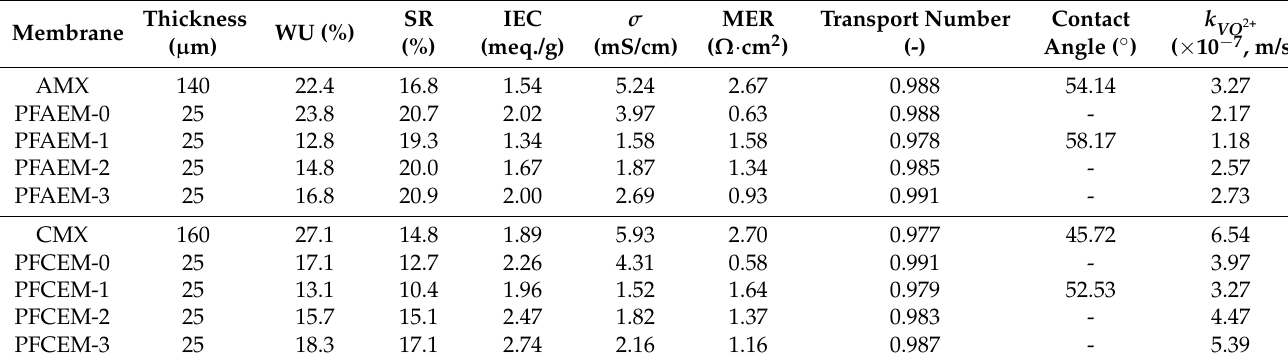
Table 5. Various properties of commercial membranes and PFIEMs.